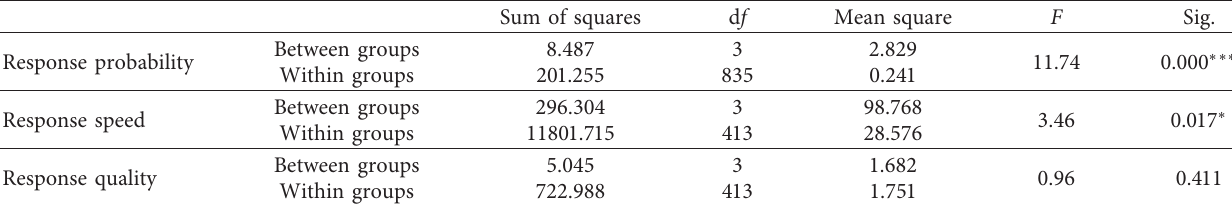
Figure 3: Provincial distributions of government response levels. (a) Success probability of appeal submission. (b) Response probability. (c) Response speed. (d) Response quality. Table 5: Regional differences of E-GR in